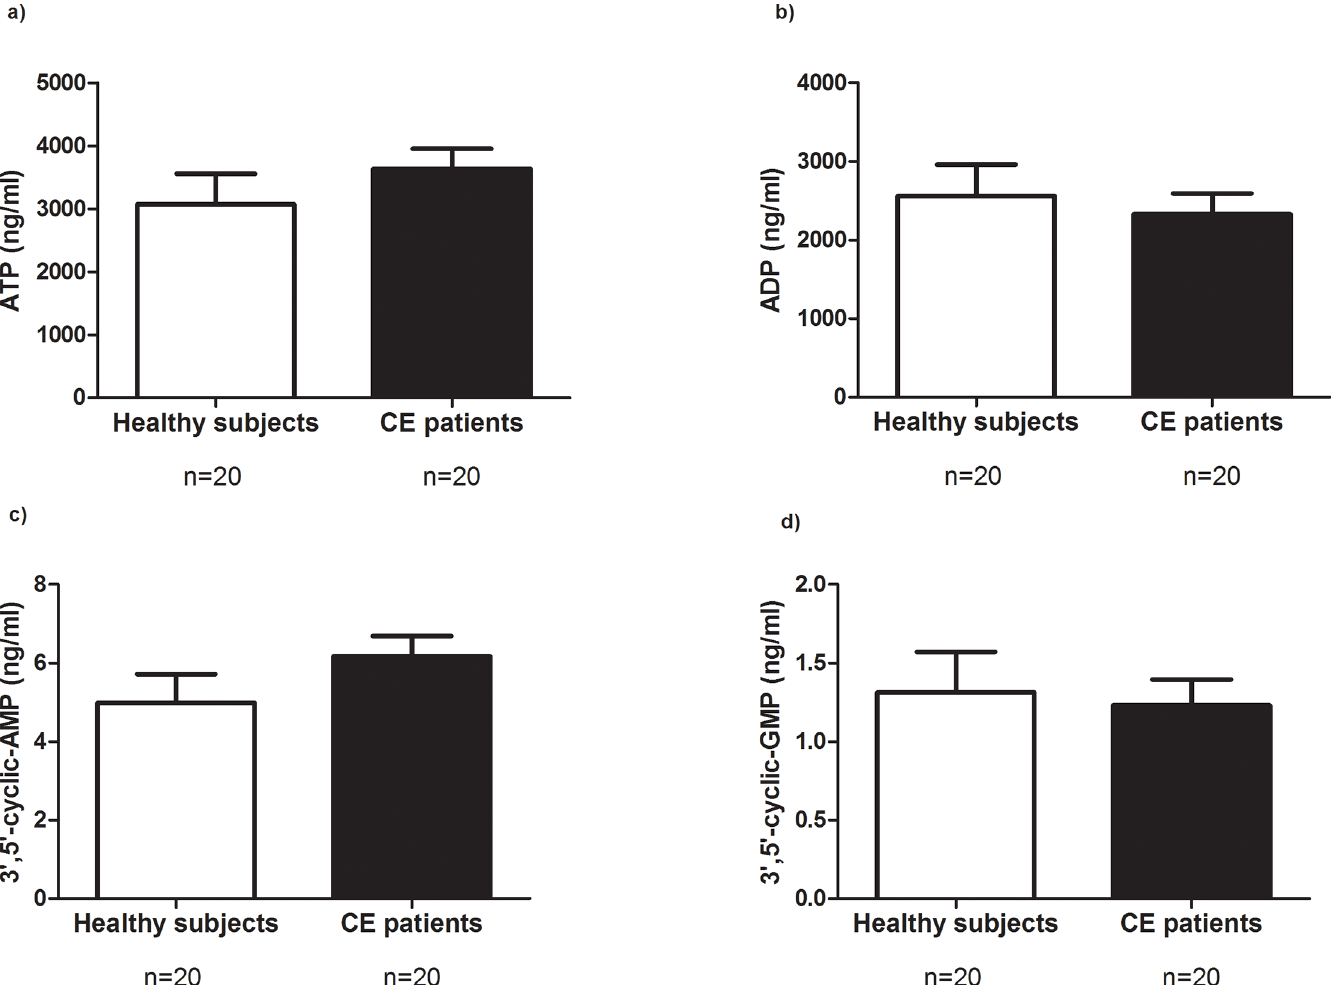
Fig 2. Plasma levels of metabolites in healthy subjects and in patients who underwent carotid endarterectomy (CE): ( a ) ATP; ( b ) ADP; ( c ) 3’,5’-cyclic-AMP; ( d ) 3’,5’-cyclic-GMP. p < 0.05 was considered to be statistically significant. ATP, adenosine triphosphate; ADP, adenosine diphosphate; AMP, adenosine monophosphate, GMP, guanosine